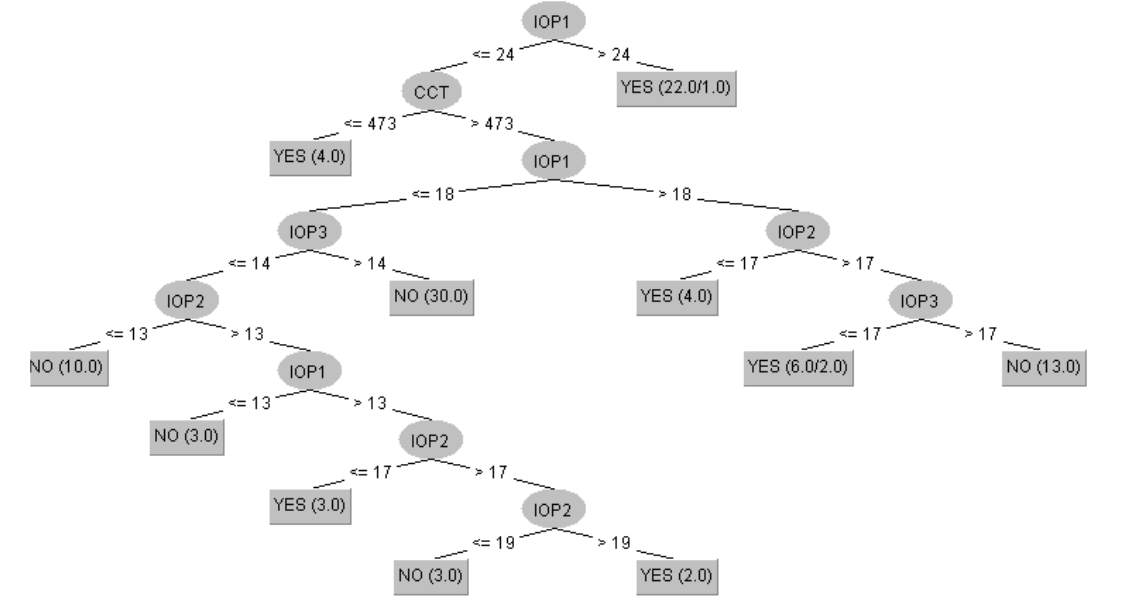
Figure 5. Decision tree of the C4.5 algorithm for predicting treatment change.